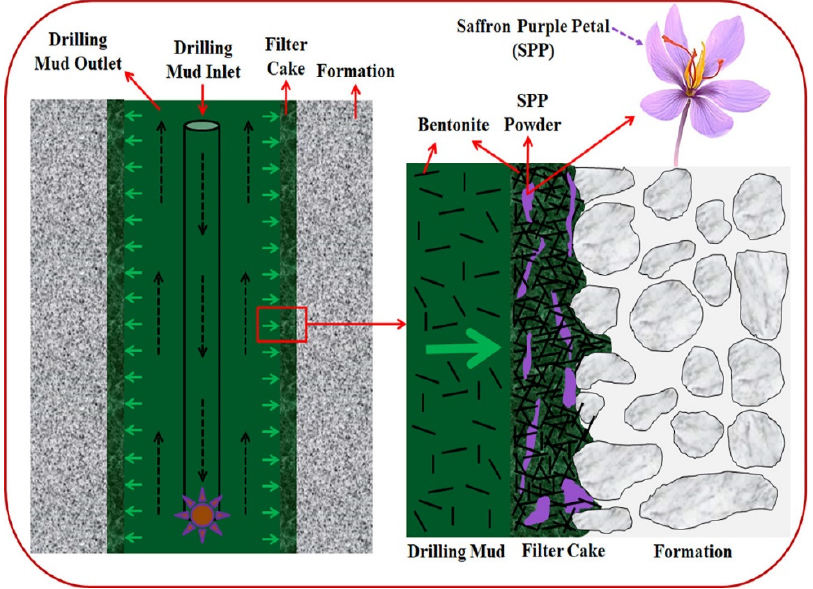
Figure 4. Schematic illustration of mud cake thickness and filter loss using saffron purple petals compared to bentonite based mud [56].